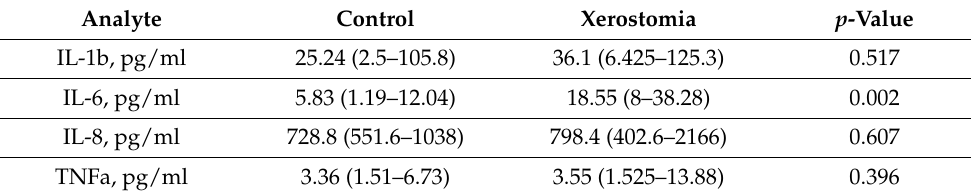
Table 3. Analysis of interleukins and TNFa in patients with xerostomia and the